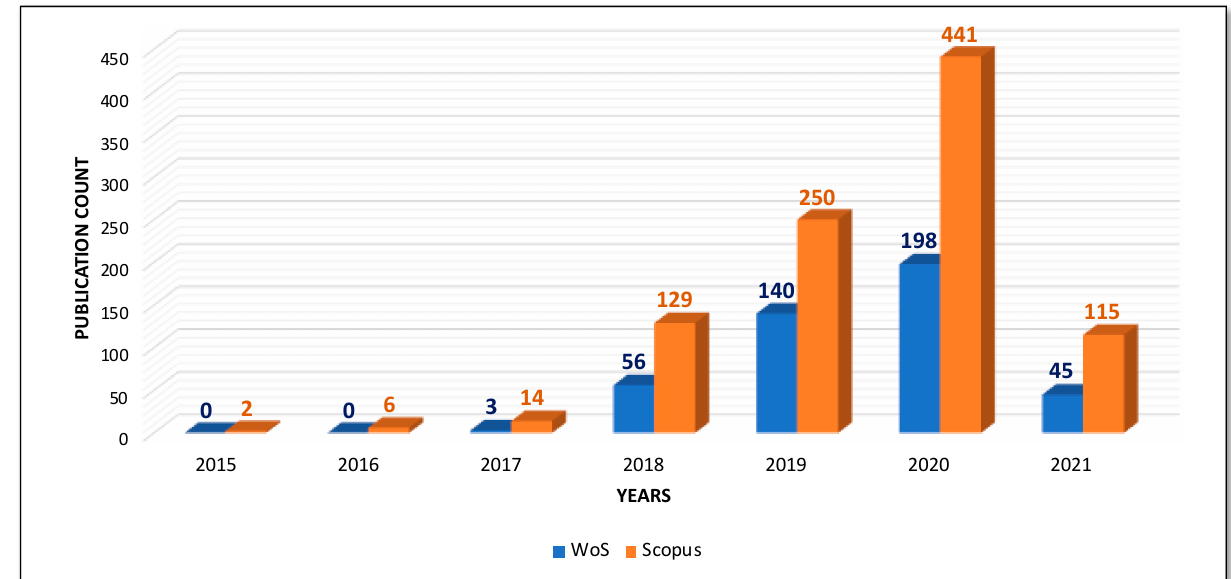
Figure 4. Comparative analysis of documents by years.